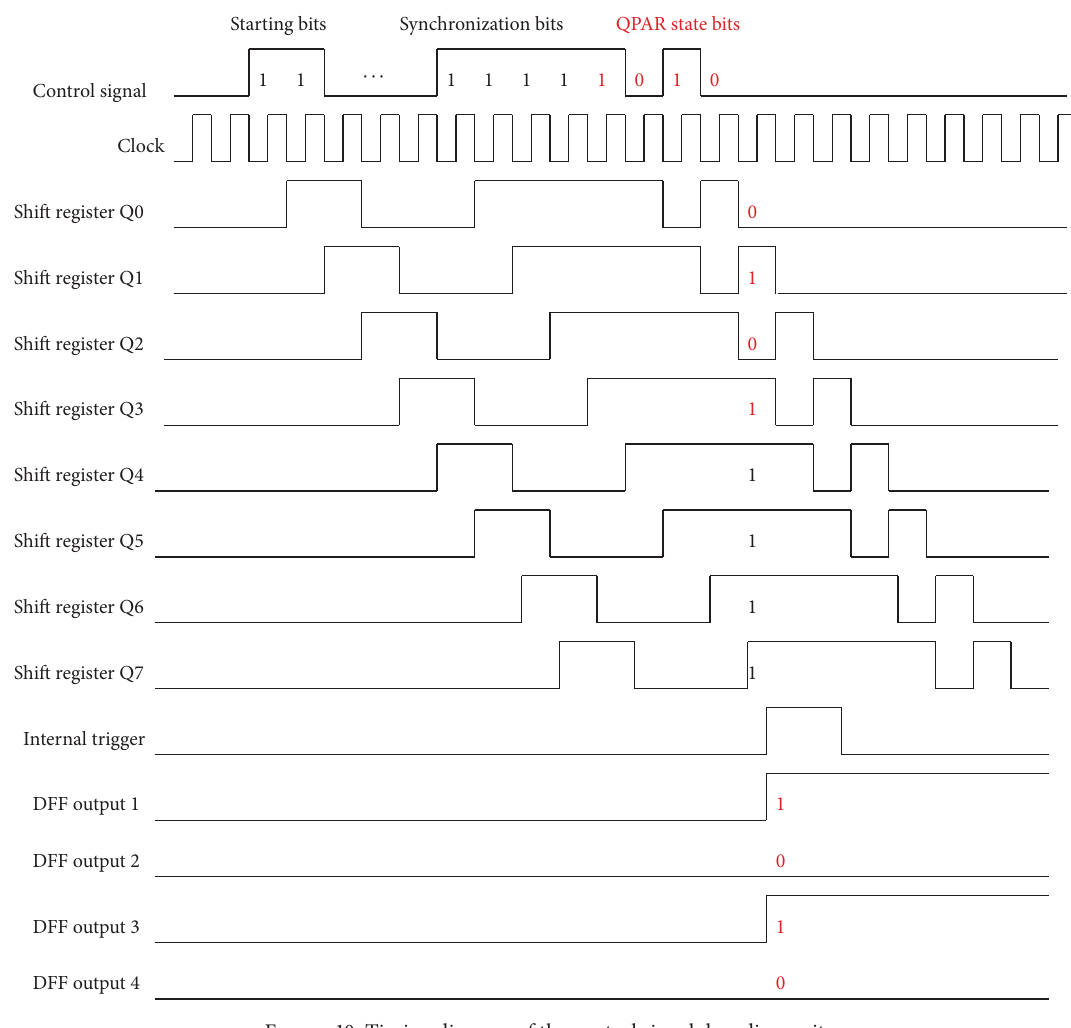
Figure 10: Timing diagram of the control signal decoding unit.